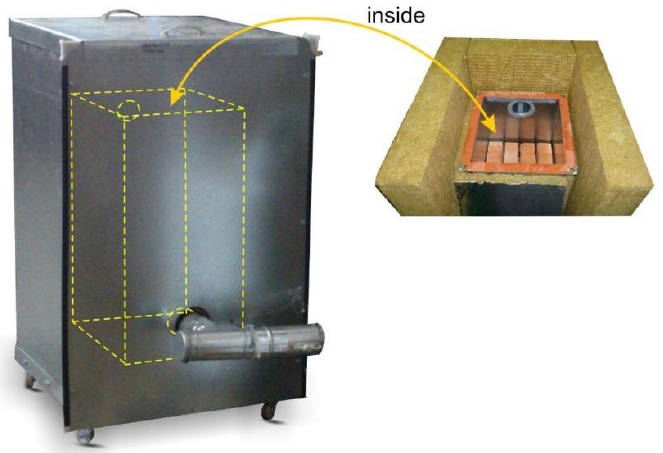
Figure 3. Experimental set-up for examining heat storage process in the rock bed.